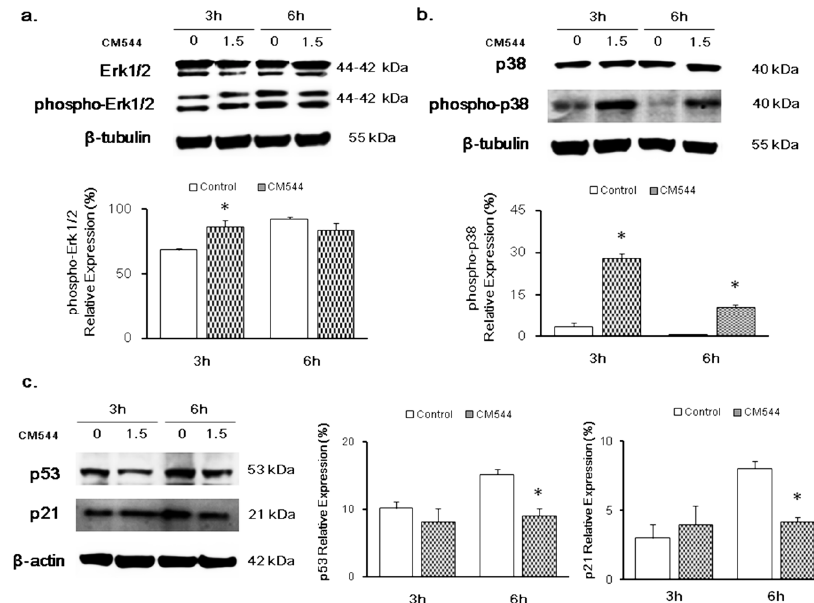
Figure 5. Modulation of MAPKs and p53-p21 in C6 rat glioma cells in the presence of CM544. Representative protein bands obtained by Western blot analysis. ( a ) Erk 1/2 and pErk 1/2 protein expression. ( b ) p38 and pp38 protein expression. ( c ) p53 and p21 protein expression. β -tubulin and β -actin expression are used as protein content markers. Typical results from one of three independent experiments are shown. Densitometric values are expressed as percentages of the integrated optical intensity of protein bands normalized on β -tubulin and β -actin. * p < 0.05 treated vs. control (untreated cells). ** p < 0.01 treated vs. control (untreated cells).